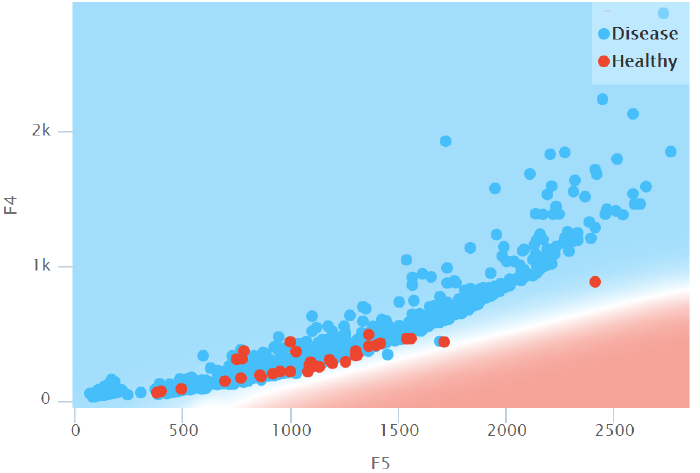
Figure 3. Scatterplot for the F 4 (i.e., Bandwidth) and F 5 (i.e., Spectral Roll-Off)